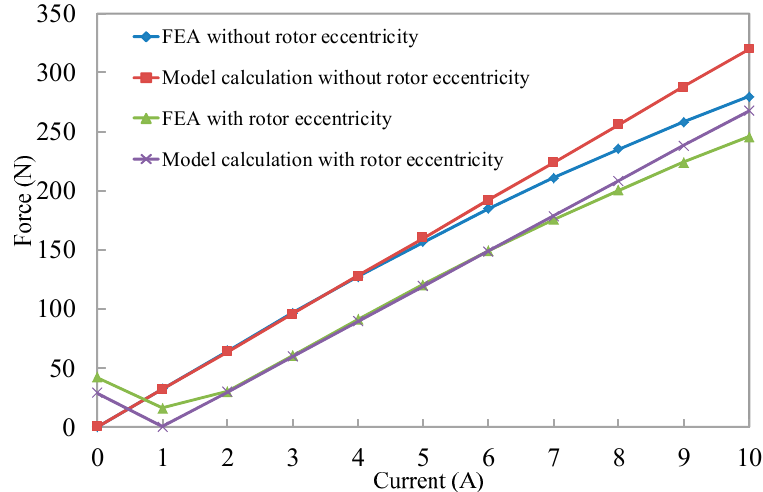
Figure 9. The relationship between radial levitation force and levitation force winding current amplitude.